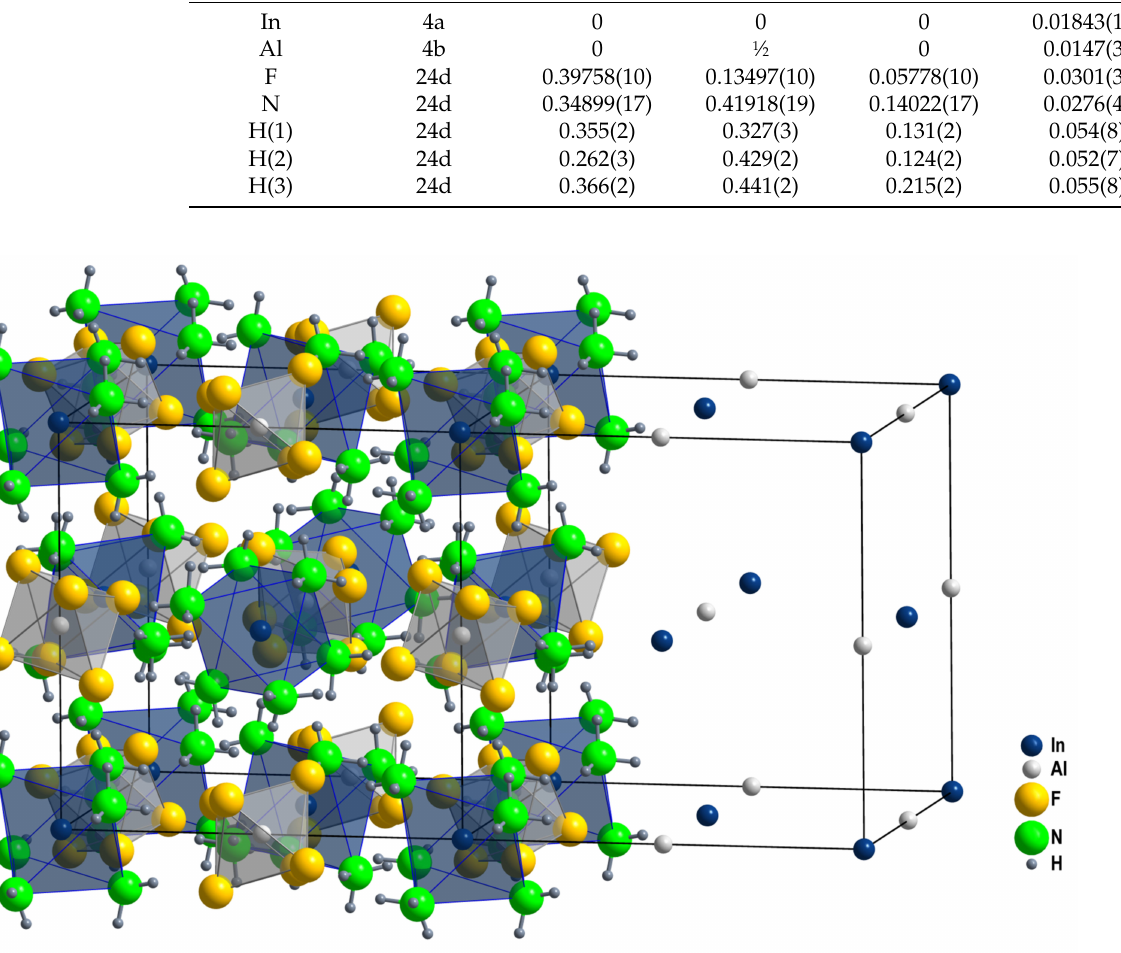
Figure 5. Section of the crystal structure of [In(NH 3 ) 6 ][AlF 6 ] with indicated unit cells on the right, reduced to the central In and Al atoms illustrating the NaCl structure-type